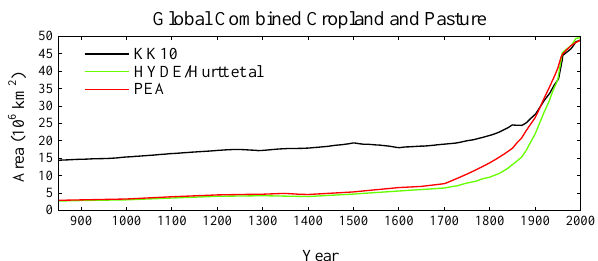
Fig. 1. Global combined cropland and pasture area in the “Kaplan and Krumhardt 2010” (KK10), Pongratz et al. (2008) (PEA) and the extended HYDE 3.1 (Hurtt et al., 2009; Klein Goldewijk et al., 2011) datasets.